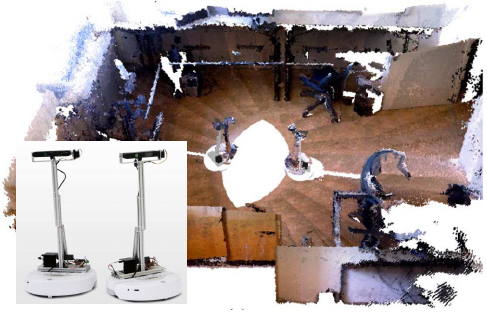
Figure 1. An example of 3D indoor mapping with two simultaneously operating mobile RGB-D sensor platforms